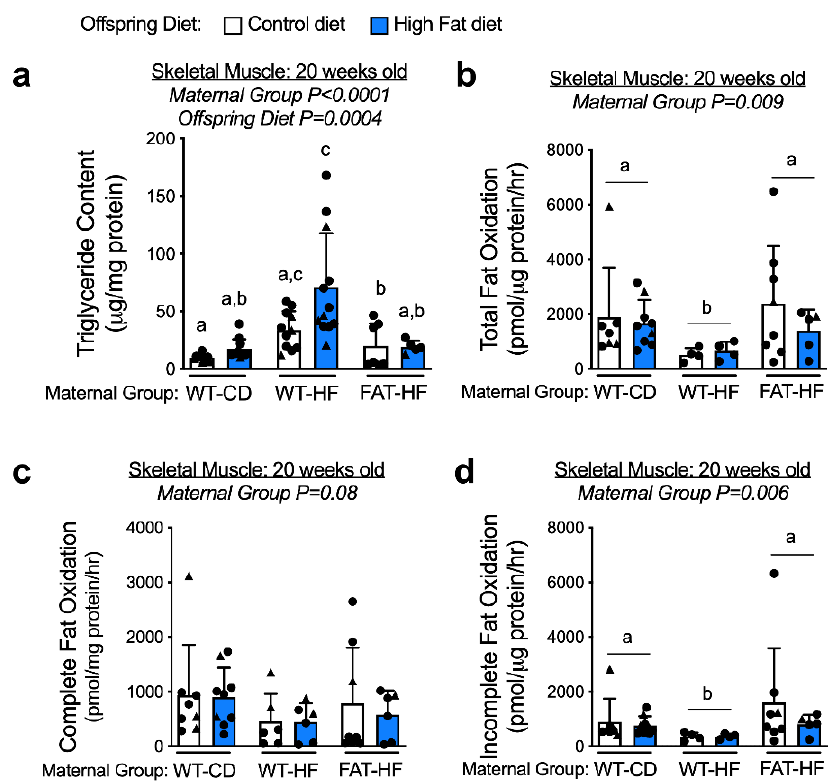
Figure 6. Maternal fat-1 transgene protects offspring from excess intramuscular triglyceride and lower fatty acid oxidation. Skeletal muscle triglyceride content ( a ), and total ( b ), complete ( c ), and incomplete ( d ) fatty acid oxidation were measured in offspring of WT dams fed a control diet (WT-CD), or offspring of WT or fat-1 hemizygous dams fed a high-fat diet (WT-HF and FAT-HF, respectively) throughout pregnancy and lactation. All offspring were WT males (circles) and WT females (triangles) and were weaned to control or high-fat diet (post-weaning diet). Data are presented as mean ± SD. Different letters above bars denote statistically significant differences between those bars at p < 0.05 significance level.